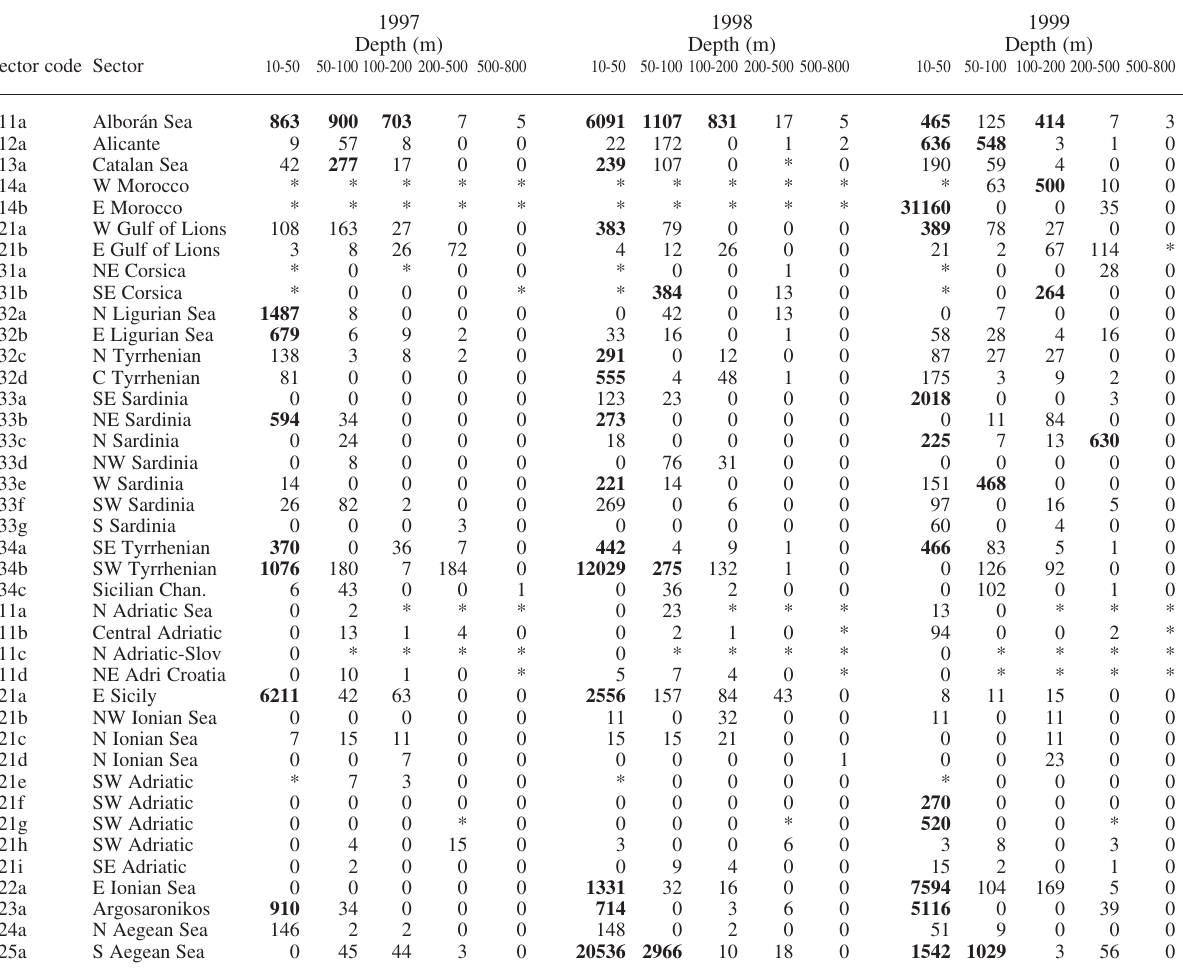
slope of the Alborán Sea (205 individuals·km -2 , CV%=98.5) in 1996, in the North Aegean Sea (182 individuals·km -2 , CV%=38.0) in 1999, and in the South Sea (193 individuals·km -2 , CV%=38.0) in 1998. Mean lengths (Fig. 3) correspond to 2,937 indi- viduals from the shelf and to 4,017 individuals from the slope. The smallest fish (3 cm) were observed in the Ligurian-North Central Tyrrhenian Sea and the South Tyrrhenian Sea shelves, in 1994 and 1996, respectively. The largest length (48 cm) was record- ed on the slope in the Gulf of Lions in 1996 and 1998. Generally, the mean lengths of fish from the shelf were lower than those from the slope. The mean lengths from west to east showed a highly sig- nificant (p<0.05) decreasing trend both on the shelf and